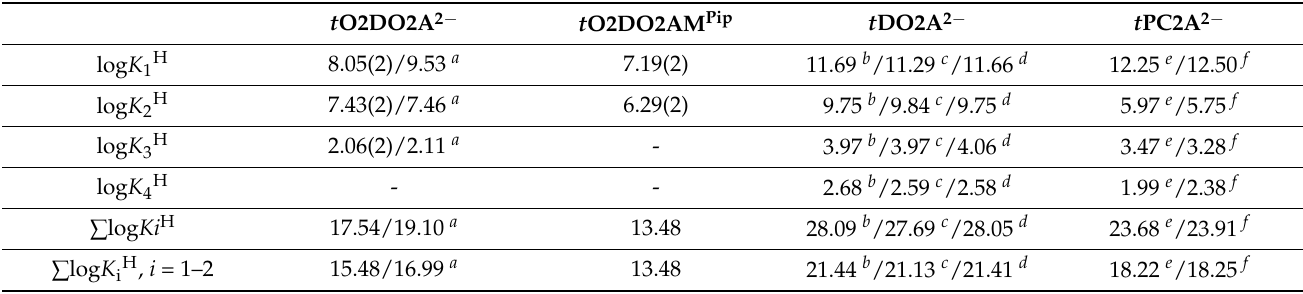
Table 2. Protonation constants of t O2DO2A 2 − and t O2DO2AM Pip ( I = 0.15 M NaCl, T = 25 ◦ C) and related ligands provided for comparison.